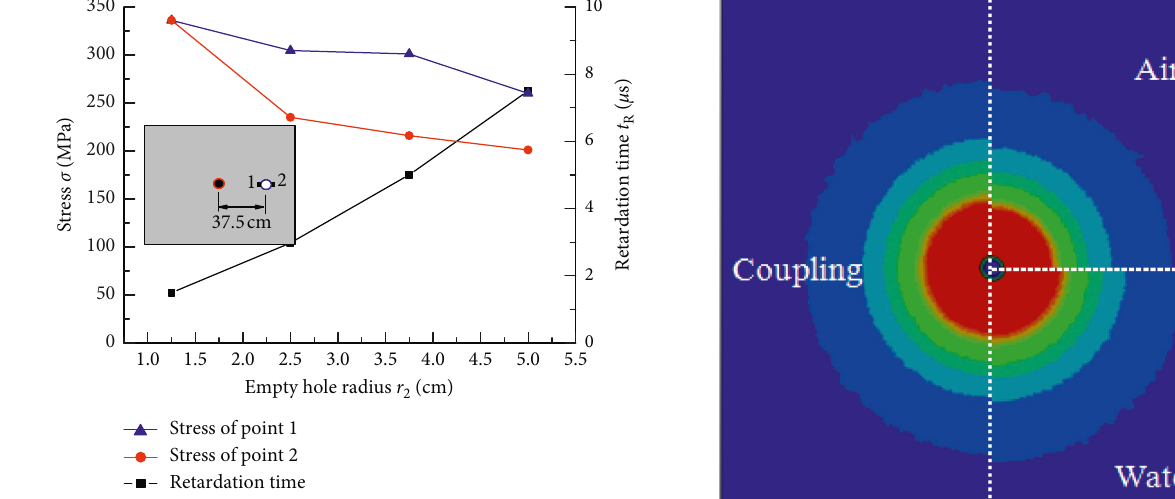
Figure 14: The stress of point 1 and point 2 on empty hole